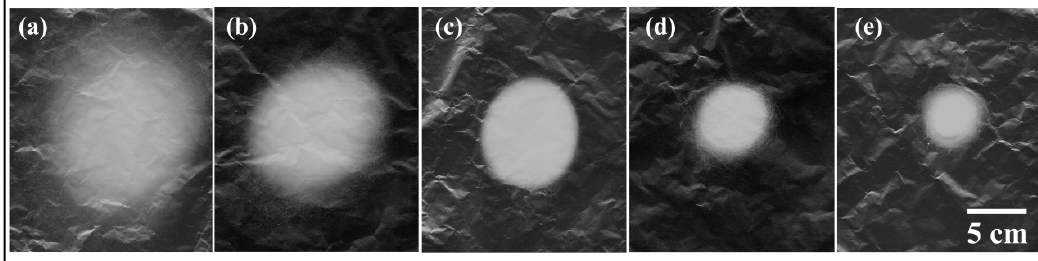
Figure 8. Fiber mats collected from five different solution concentrations by flat collectors: ( a ) 10 wt %; ( b ) 15 wt %; ( c ) 20 wt %; ( d ) 25 wt %; ( e ) 30 wt %. The collecting time is set to be 10 min. The processing parameters are as follows: Applied voltage of 20 kV, working distance of 20 cm, and flow rate of 1.0 mL/h.